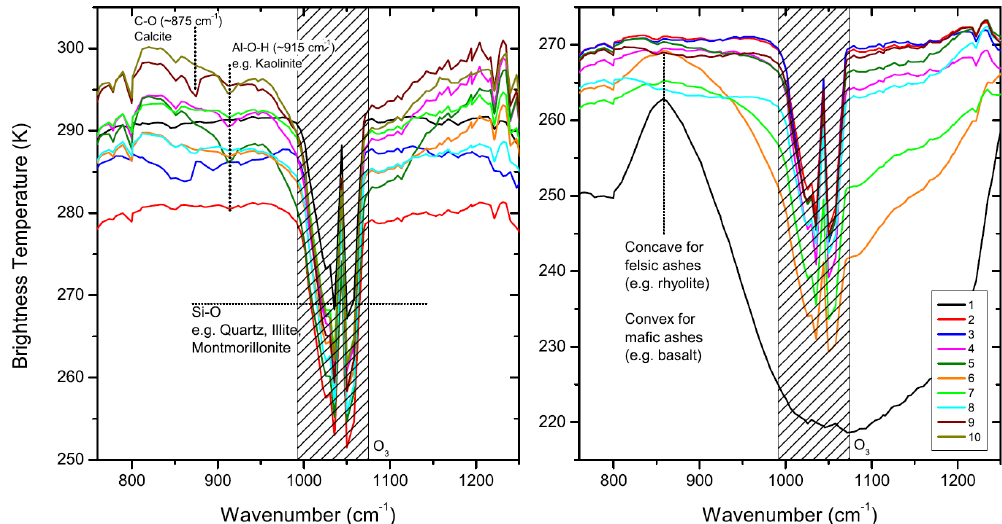
Fig. 4. Clustered mean spectra for sand (left panel) and volcanic ash (right panel) as generated by the k -means algorithm on spectra observed over a variety of airborne sand and ash plumes, respectively. The broadband V-shape absorption between 800–1200cm − 1 due to Si-O is seen in most spectra. Some other mineral features are depicted as well. The spectral region with the large absorption due to O 3 is grayed